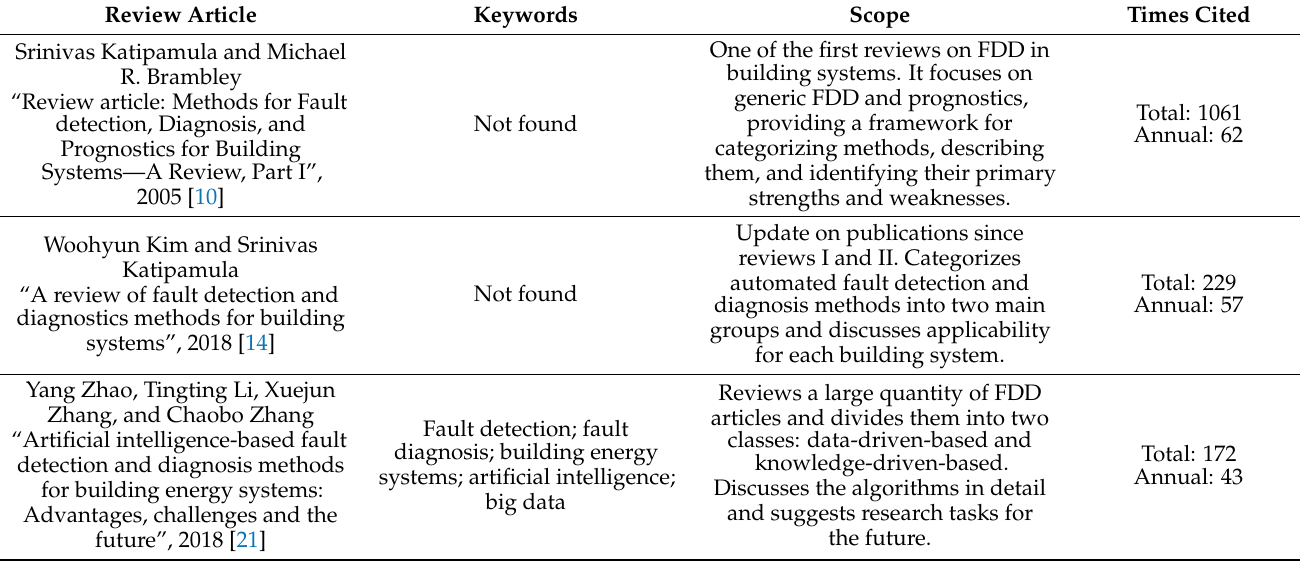
Table 1. Reviews on fault detection and diagnosis in building systems. Times cited are from Google Scholar and were collected in April